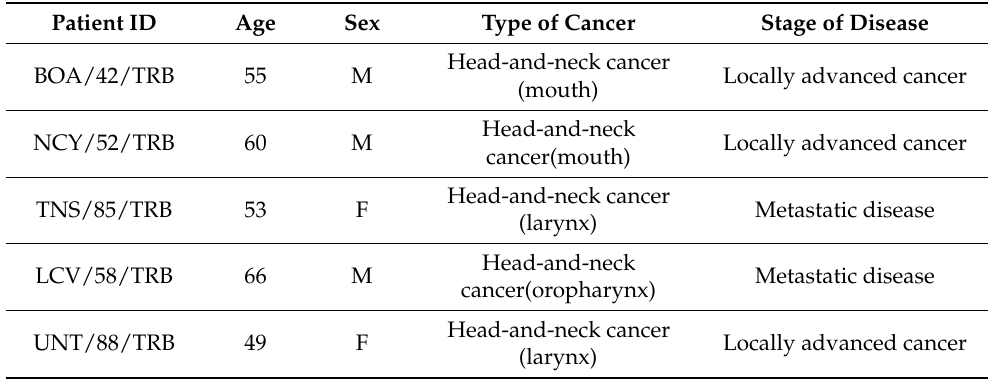
Table 1. Patients’ characteristics and stage of